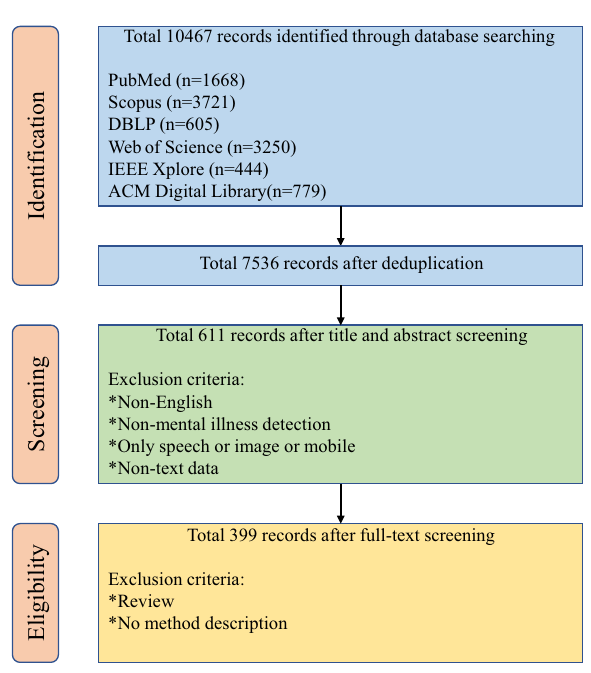
Fig. 1 Overview of article selection process. Six databases (PubMed, Scopus, Web of Science, DBLP computer science bibliography, IEEE Xplore, and ACM Digital Library) were searched. The fl owchart lists reasons for excluding the study from the data extraction and quality